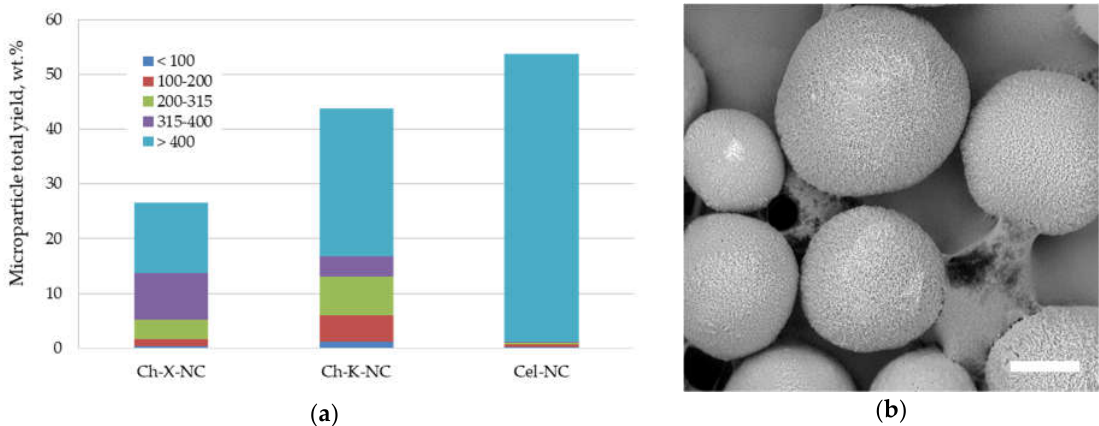
Figure 5. ( a ) Total yield and size distribution of PLA microparticles stabilized with 0.1 wt.% water dispersions of polysac- charide nanocrystals of various origins: the legend shows a size range (µm) of microparticle fractions; ( b ) SEM micrograph of PLA microparticles stabilized with 0.1 wt.% of Ch-K-NC water dispersion. The scale bar is 100 µm.